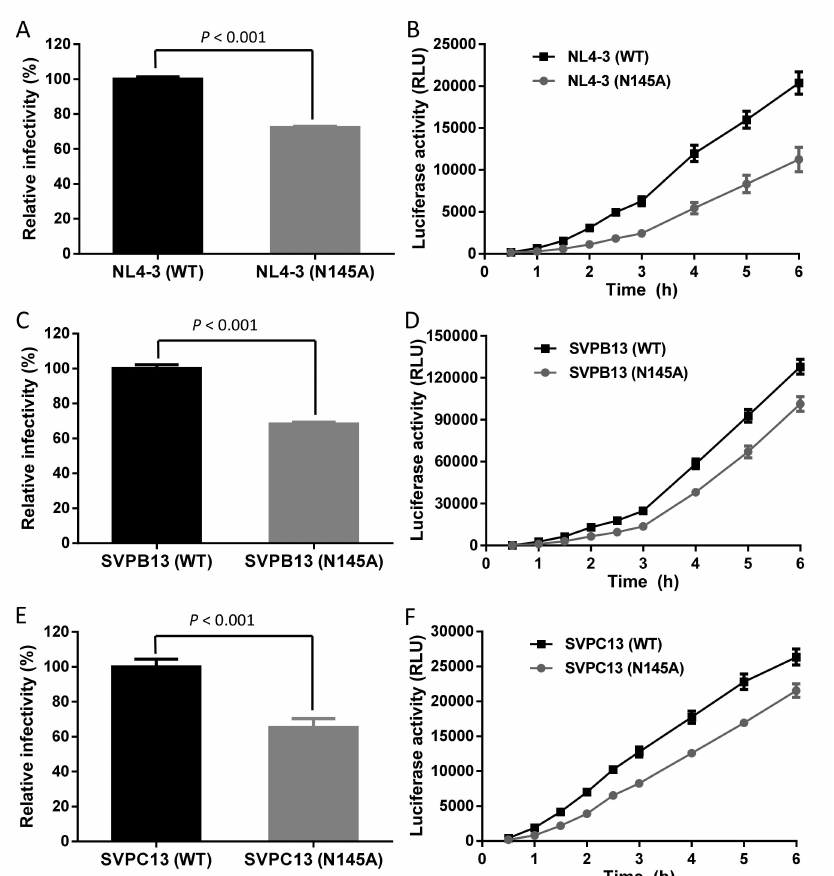
Figure 2. E ff ects of the N145A mutation on the functionality of HIV-1 Env. The N145A mutation severely impairs the HIV-1 NL4-3 pseudovirus entry ( A ) and Env-mediated cell-cell fusion ( B ), HIV-1 SVPB13 pseudovirus entry ( C ) and Env-mediated cell-cell fusion ( D ), and HIV-1 SVPC13 pseudovirus entry ( E ) and Env-mediated cell-cell fusion ( F ). The pseudovirus entry in TZM-bl cells was determined by a single-cycle infection assay, in which the wild-type (WT) and mutant pseudoviruses were normalized to a fixed amount by p24 antigen. The luciferase activity of wild-type virus was treated as 100%, and the relative infectivity of the mutant virus was calculated. A t test was performed to judge the significance of the di ff erence between the WT and mutant and p values are shown. Kinetics of HIV-1 Env-mediated cell-cell fusion was determined by a dual split-protein assay (DSP). For both viral entry and fusion, data were derived from the results of three independent experiments and are expressed as means with standard deviations